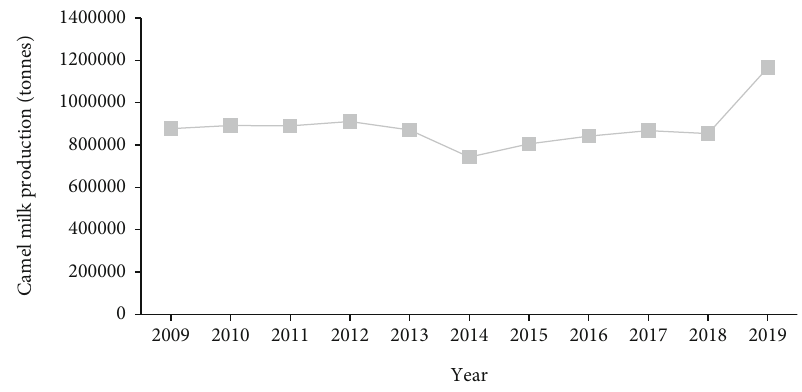
Figure 5: Camel milk production trend in Kenya for the past decade (2009 – 2019). Source: [8]. Table 4: Comparison of proximate composition of milk from di ff erent species.